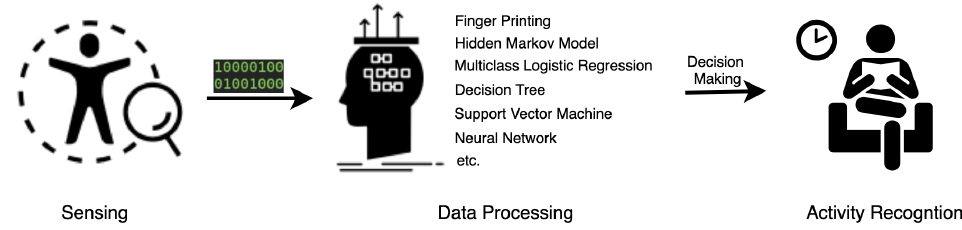
Figure 3. The general process of an HAR